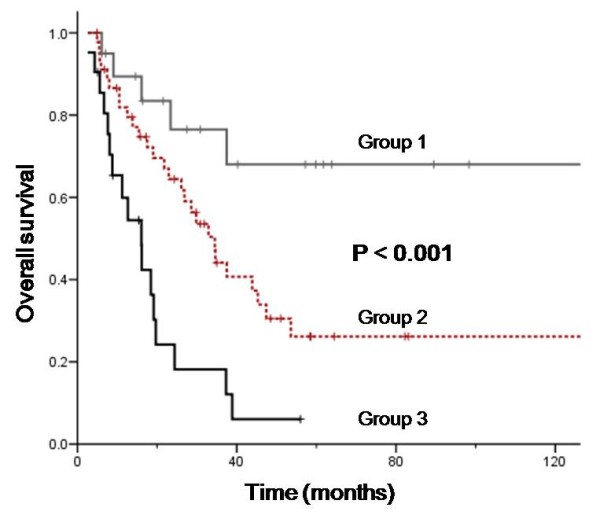
Survival according risk group as defined by prognostic models.